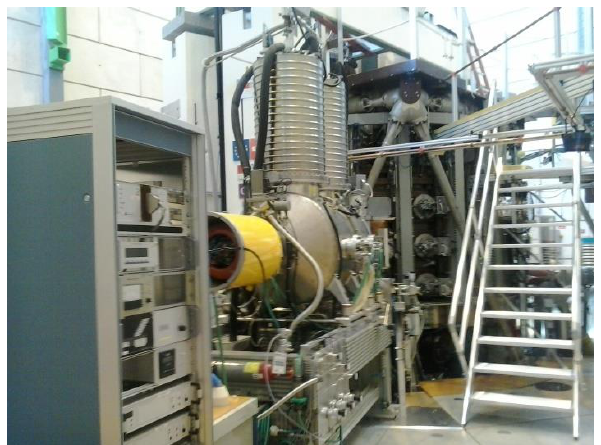
Figure 1. Partial view of the installations of Tokamak à Configuration Variable, TCV, at CRPP-EPFL.